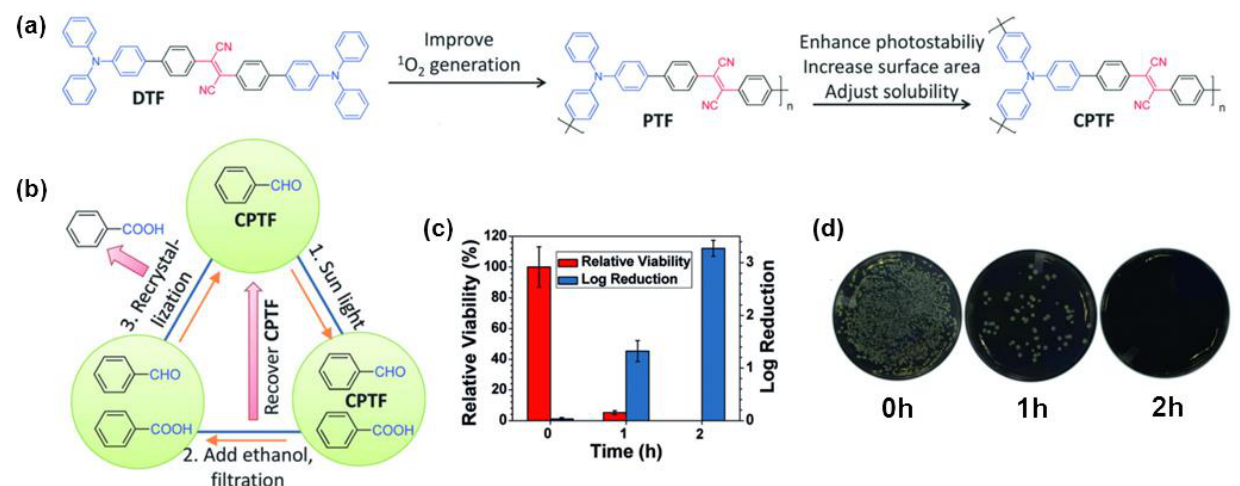
Figure 13. ( a ) The chemical structures of DTF, PTF, and CPTF. ( b ) The recycling process of sun- light-induced photooxidation of benzaldehyde. ( c ) The antibacterial activity of CPTF under differ- ent irradiation times. ( d ) Photographs of biocidal activity of CPTF-treated S. aureus upon different irradiation times. Reprinted with permission from Ref. [83]. 2019, Wiley-VCH.